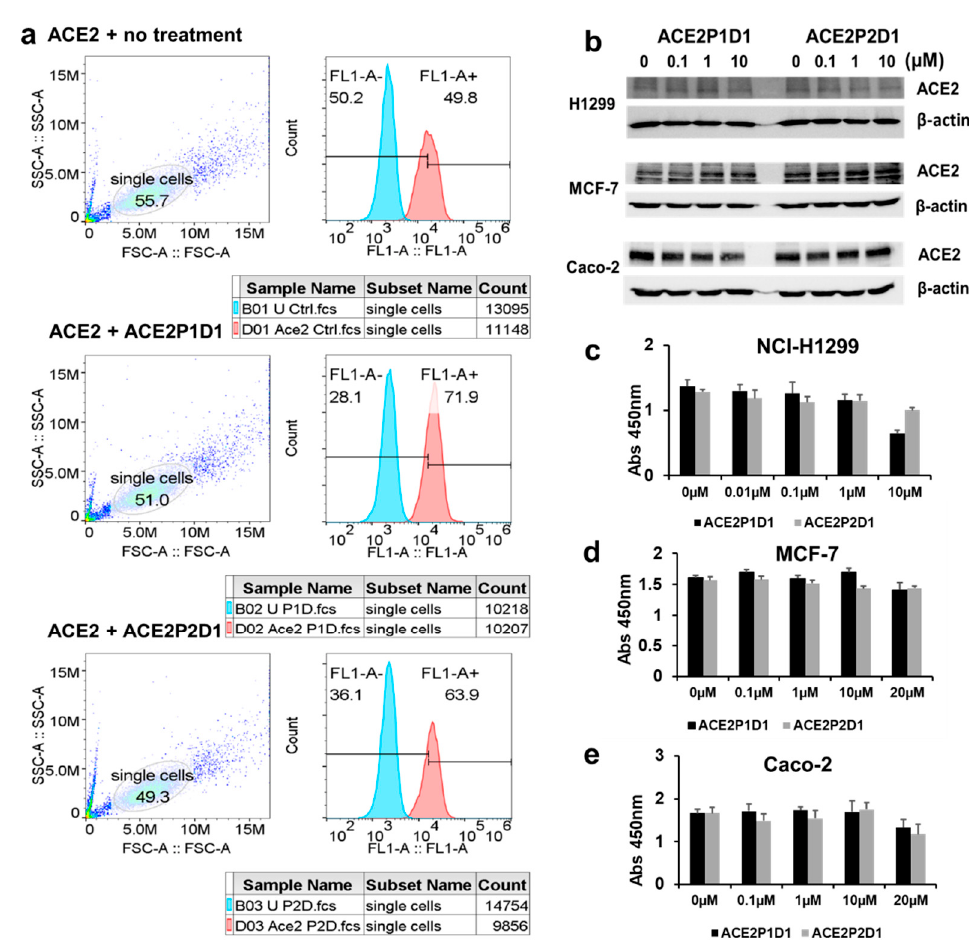
Figure 5. ACE2P1D1 and ACE2P2D1 do not decrease ACE2 expression and are not toxic to cells. ( a ) NCI-H1299 cells were treated with PBS or 10 µM of ACE2P1D1 or ACE2P2D1 for 48 h. ACE2 expression was detected by flow cytometry. ACE2 expression was not changed in ACE2P1D1 or ACE2P2D1 treated cells. ( b ) NCI-H1299, MCF-7, and Caco-2 cells were treated with various concentrations of ACE2P1D1 or ACE2P2D1 for 48 h. Total ACE2 levels in cells were analyzed by Western blot. The treatment of ACE2P1D1 or ACE2P2D1 had no effect on ACE2 protein levels. For each cell line, blots were cropped from different parts of the same gel. ( c – e ) NCI-H1299, MCF-7, and Caco-2 cells were treated with various concentrations of ACE2P1D1 or ACE2P2D1 for 48 h. Cell viability was measured by WST-1 assay. The treatment of ACE2P1D1 or ACE2P2D1 had no effect on the cell viability of NCI-H1299, MCF-7, and Caco-2 cells within the peptoid concentrations tested up to 20 µM. Each bar represents the mean + standard deviation ( n = 3–5/group).